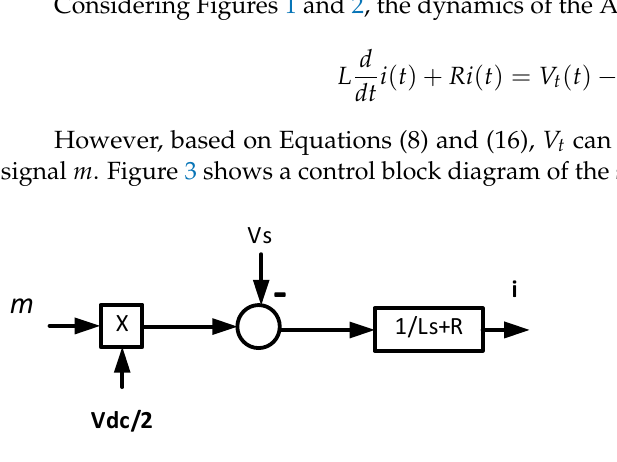
Figure 3. Control model of both converters.